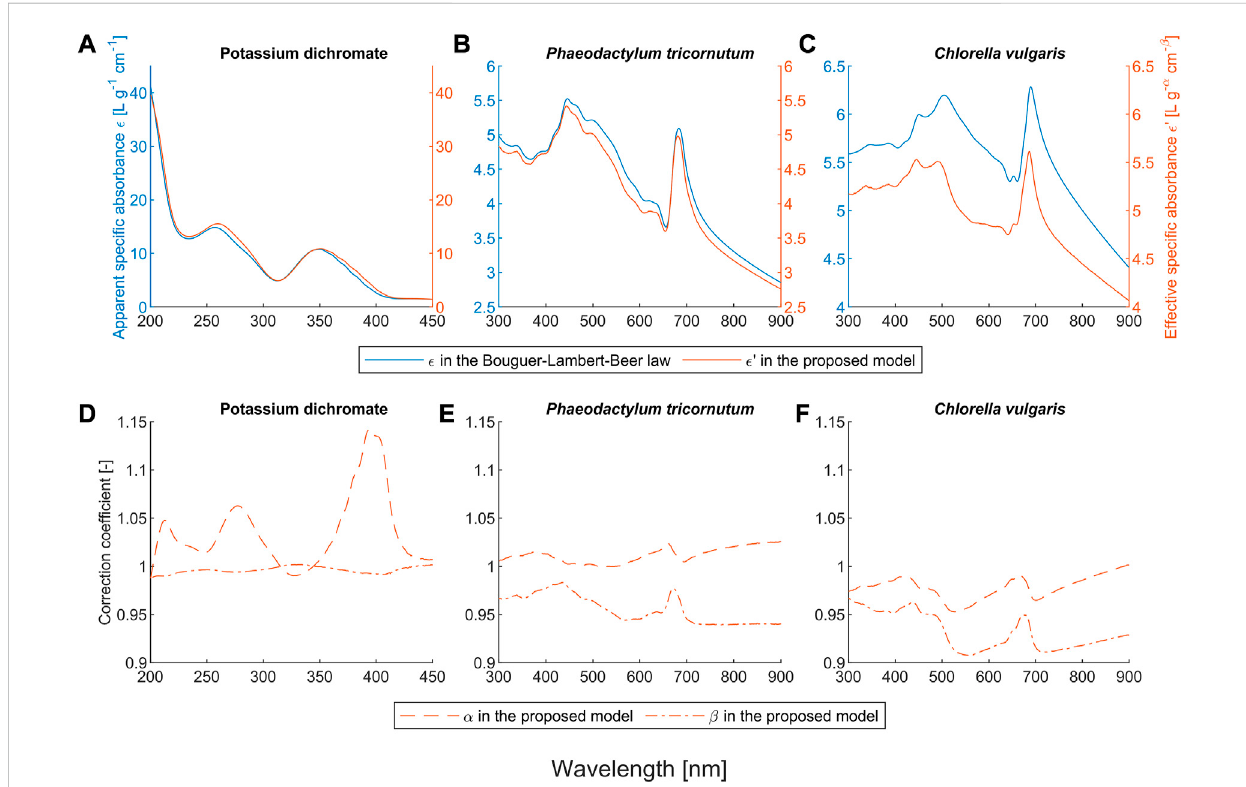
FIGURE 2 Obtained coef fi cients of the Bouguer-Lambert-Beer law and the proposed model for the potassium dichromate solutions and the microalgae suspensions. Here, ε denotes the apparent speci fi c absorbance in the BLB law. For the proposed model, ε ′ is the effective speci fi c absorbance, α the correction coef fi cient of the concentration, and β the correction coef fi cient of the path length.